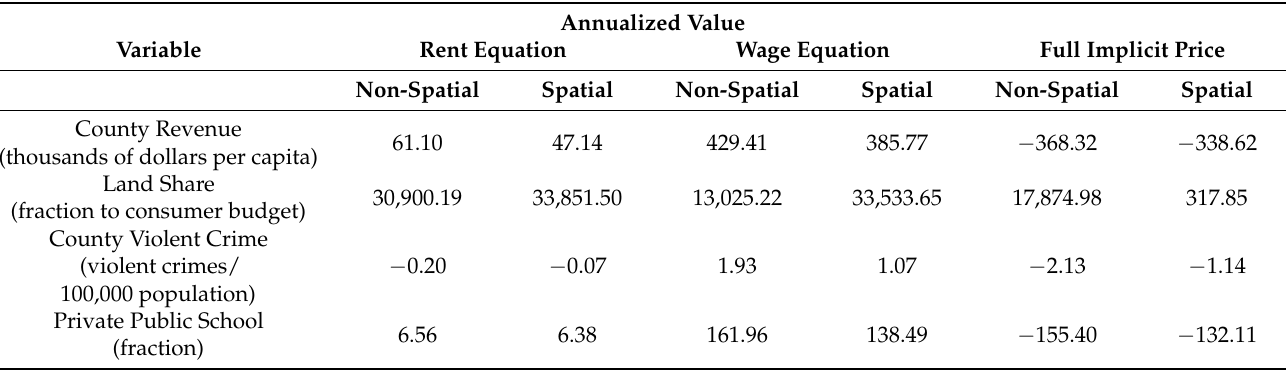
Table 5. Annualized values based on non-spatial and spatial models for the